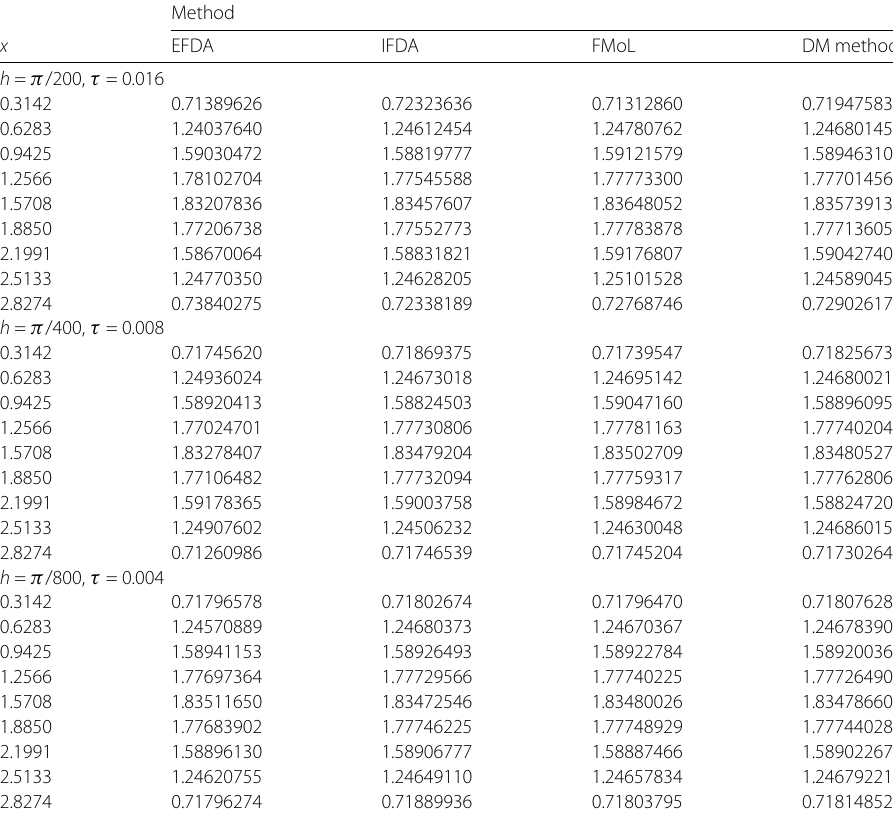
Table 2 Values of the approximate solution of problem (57) at different values of x and T = 1, using Ω = (0, π ), α = 1.8, and K = 0.1. Computationally, we used different combinations of values of h and τ . The results were obtained using the EFDA, IFDA, and FMoL reported in [36], as well as the DM method introduced in the present manuscript Method x EFDA IFDA FMoL DM method h = π /200, τ = 0.016